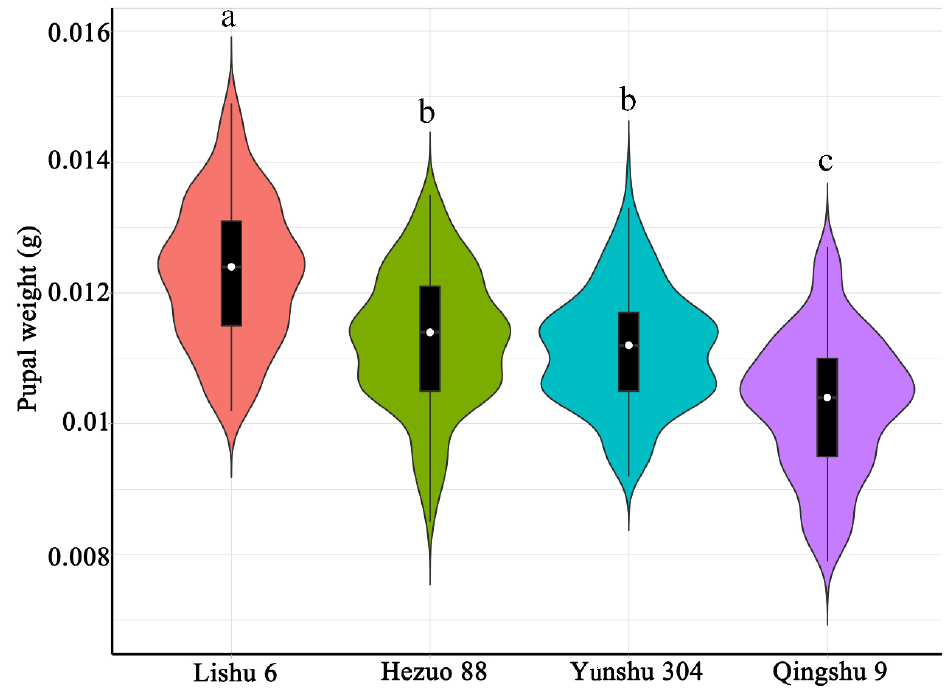
Figure 3. Pupal weight of P. operculella on four different potato tuber varieties. Different lowercase letters indicate means are significantly different at p < 0.001.